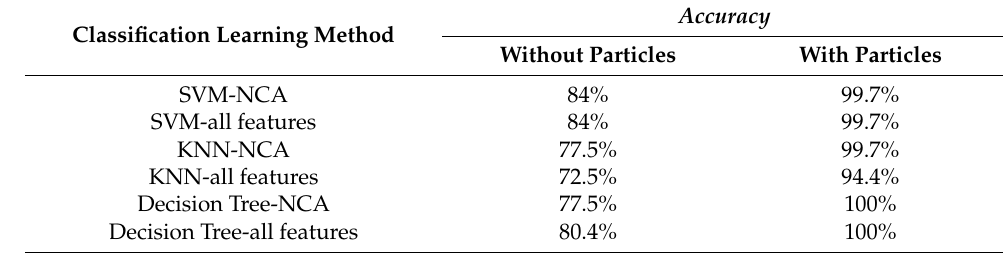
Figure 17. Confusion matrix using Tree-NCA method ( a ) without particles ( b ) with particles. Table 6. Classification accuracy (mean) with different methods.